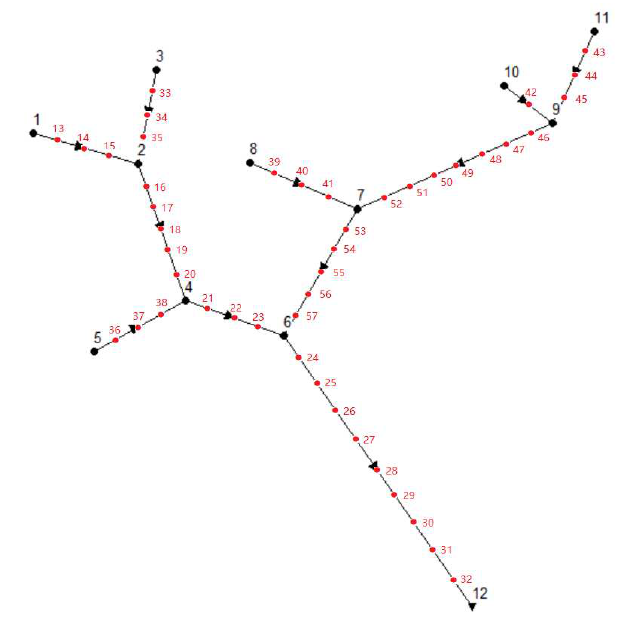
Figure 8. Hypothetical river network with more potential monitoring